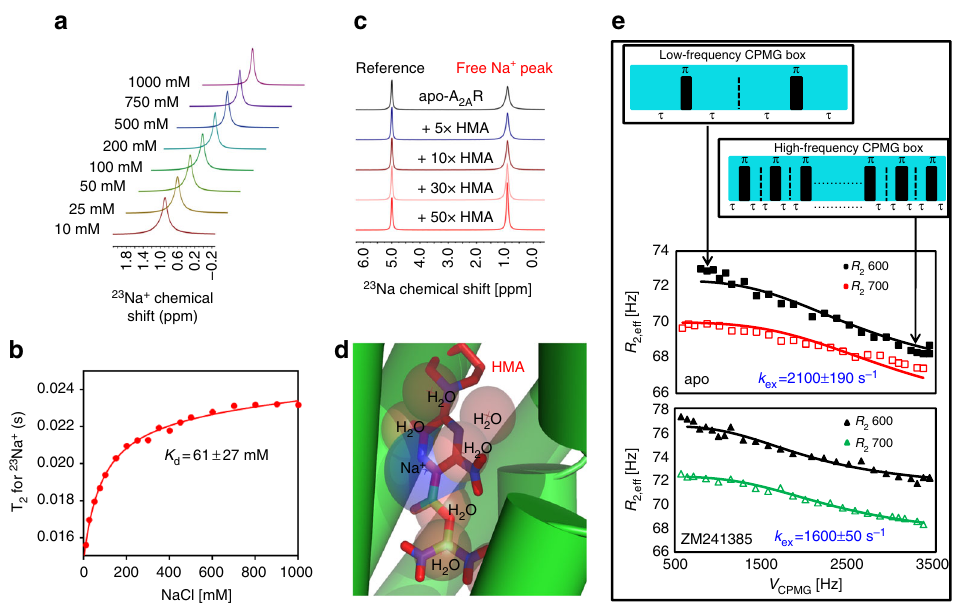
Fig. 2 Effect of the allosteric modulator HMA on the sodium pocket. a 23 Na NMR spectra as a function of Na + concentration (10 – 1000mM NaCl) in the presence of 50 μ M apo A 2A R-V229C. b Line width-based binding isotherm for NaCl derived from ( a ), showing a dissociation constant of K d , of 61 ± 27 mM. (The deviation was de fi ned by three replicates and was applied into all ±values unless described otherwise.) c 23 Na NMR spectra of A 2A R-V229C, in the presence of 100 mM NaCl, as a function of stoichiometric equivalents of the allosteric modulator HMA. d Low-energy pose of HMA docked to A 2A R in the absence of sodium, showing sodium (purple) and water molecules (red) from PDB ID: 4EIY, overlaid with HMA, which was docked in the absence of sodium and internal water molecules. e 23 Na NMR CPMG relaxation series of apo A 2A R-V229C. Each spectrum was acquired using 256 scans with a constant T 2 -refocusing period of 70 ms and a pulse refocusing frequency, Ѵ CPMG , as described in the fi gure. Note that no discernible dispersion was observed with the identical experiment performed in the presence of MNG-3 detergent micelles without A 2A